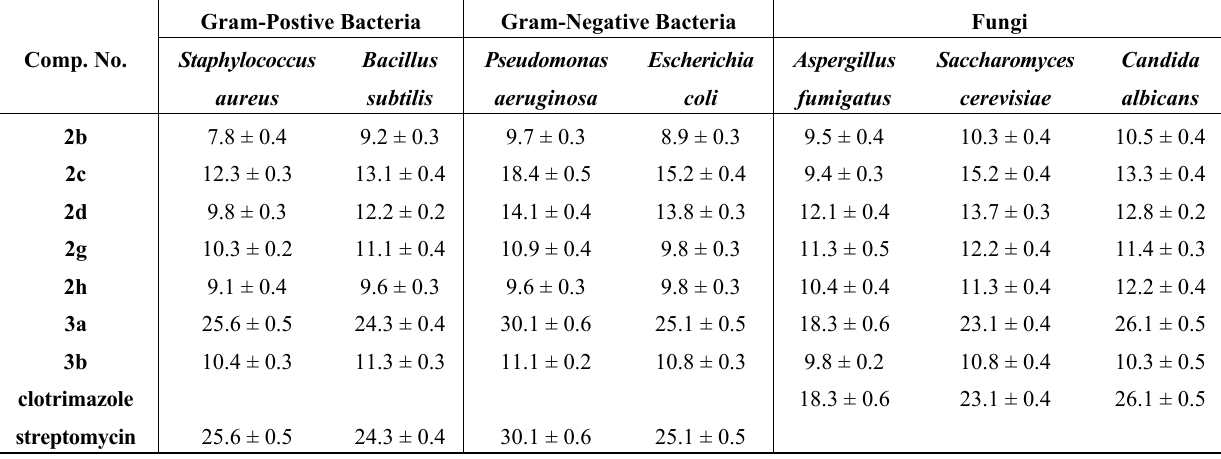
Table 1. Antimicrobial evaluation of the synthesized